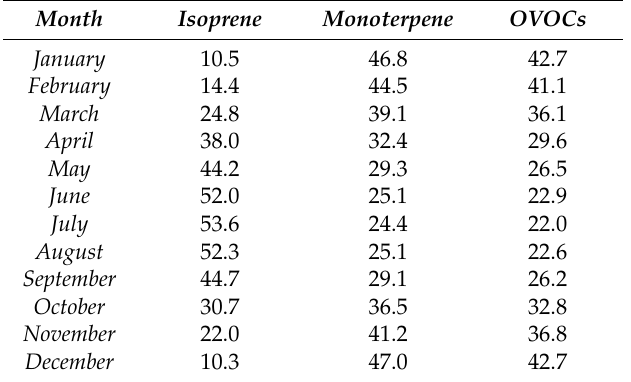
Table 2. Percentage (%) of contribution of each hydrocarbon to the total monthly biogenic emissions.